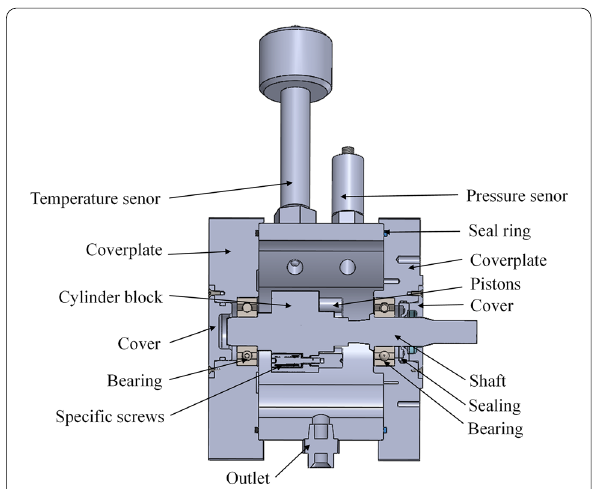
Figure 1 The physical model of the churning losses test pump